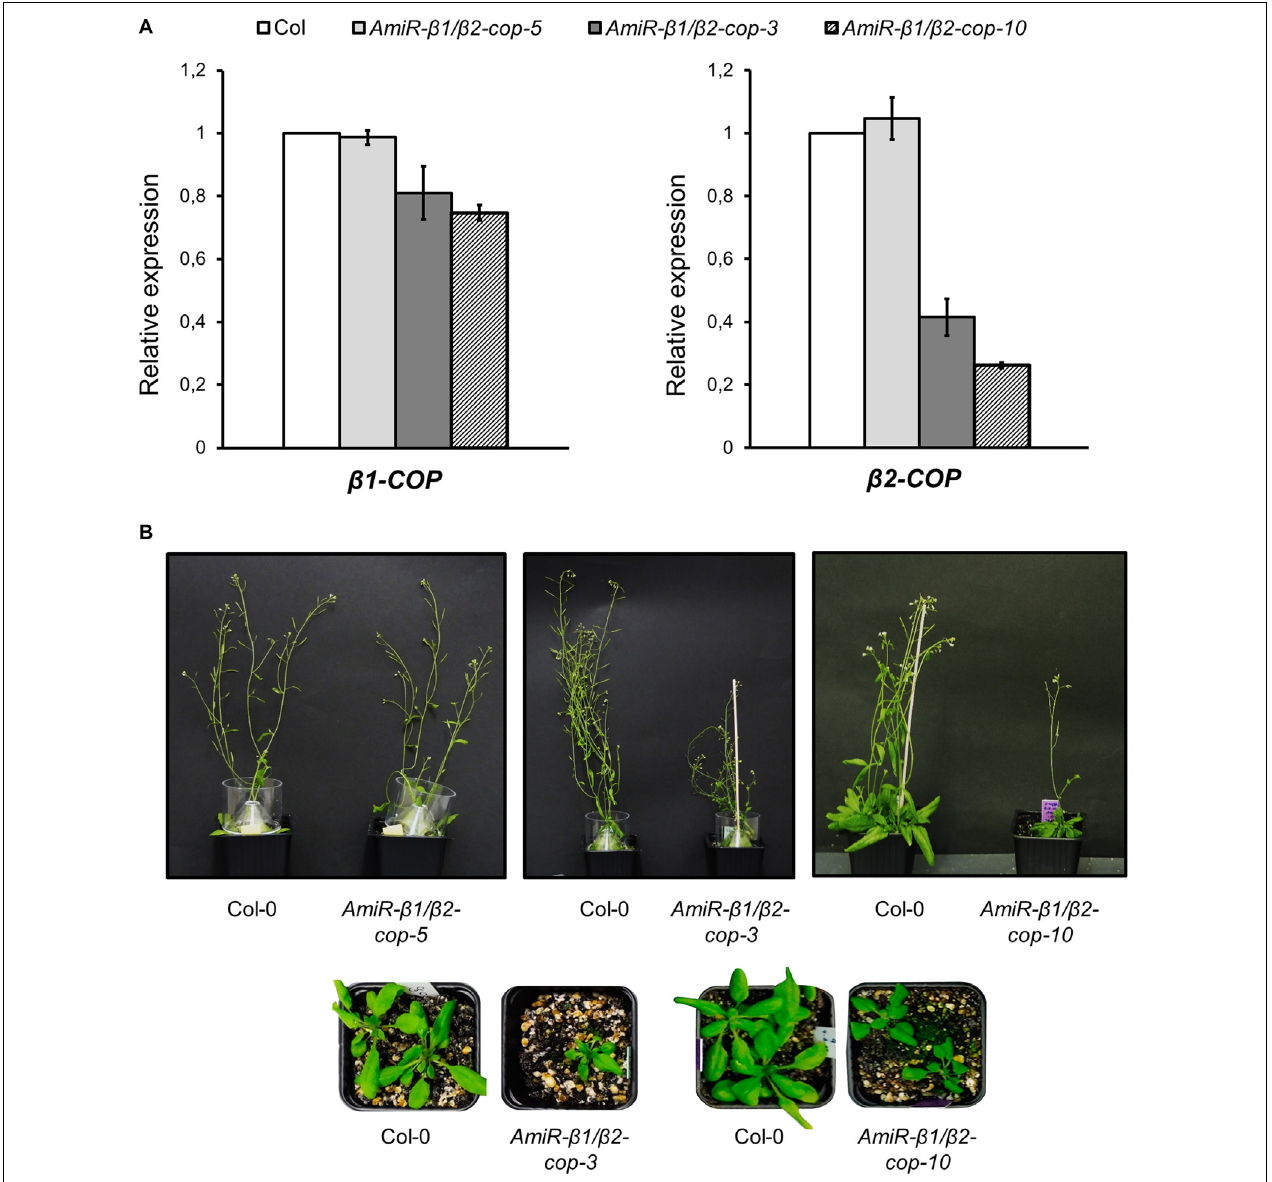
FIGURE 4 | Characterization of amiR- β 1/ β 2-cop mutants. (A) RT-qPCR analysis to show the silencing of β 1-COP and β 2-COP in the amiR- β 1/ β 2-cop lines. Total RNA was extracted from 4 days seedlings of the amiRNA lines amiR- β 1/ β 2-cop-3 , amiR- β 1/ β 2-cop-5, amiR- β 1/ β 2-cop10 and wild type (Col-0). The mRNA was analyzed by RT-qPCR with specific primers and normalized to UBQ10 expression ( Supplementary Table S2 ). Results are from three biological samples and three technical replicates. mRNA levels are expressed as relative expression levels and represent fold changes of mutant/wild type. Values represent mean ± s.e.m of the three biological samples. (B) Phenotypes of amiRNA lines and wild type (Col-0) plants. Line 5: 36 day-old plants. Line 3: 26 (lower panel) and 50 day-old-plants (upper panel). Line 10: 26 (lower panel) and 36 day-old plants (upper